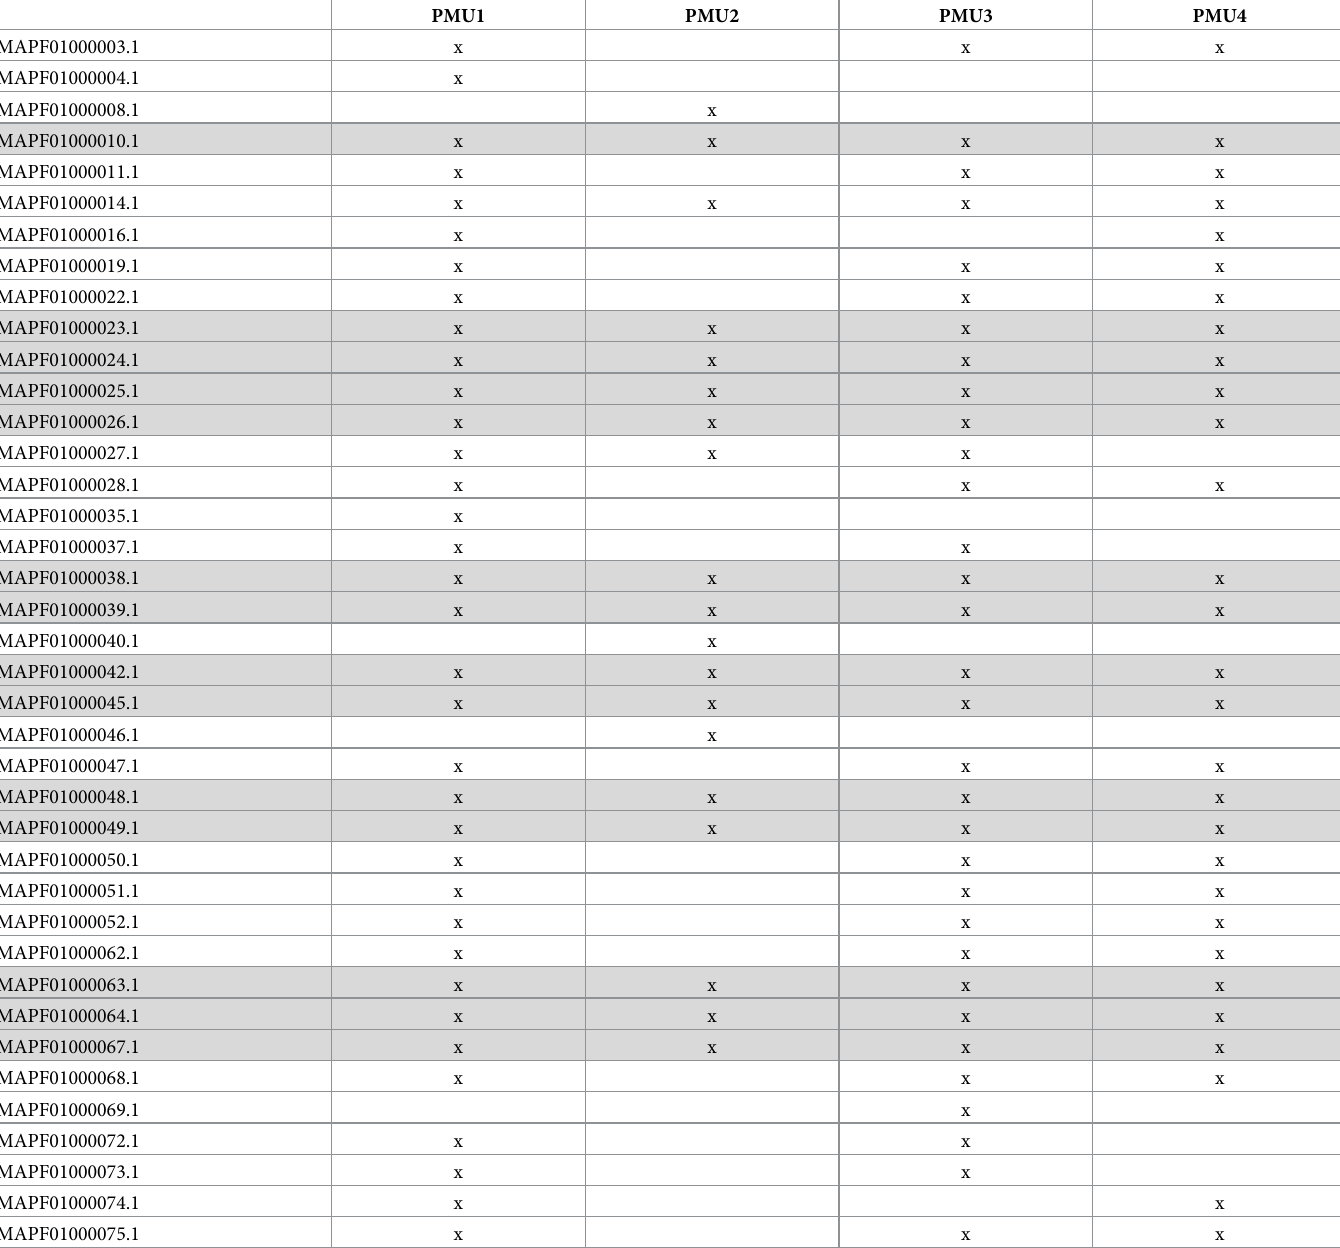
Table 3. Contigs from NJAY chromosomal assembly exhibiting hits to PMUs of the AY-WB chromosome.